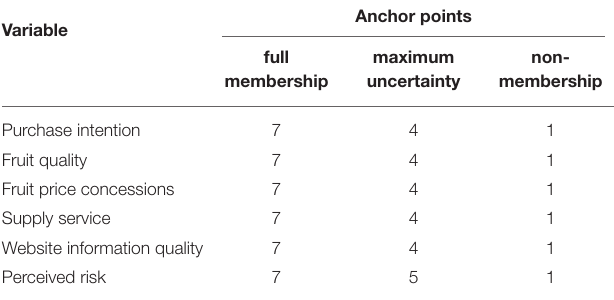
fsQCA 3.0 used the truth table algorithm to obtain